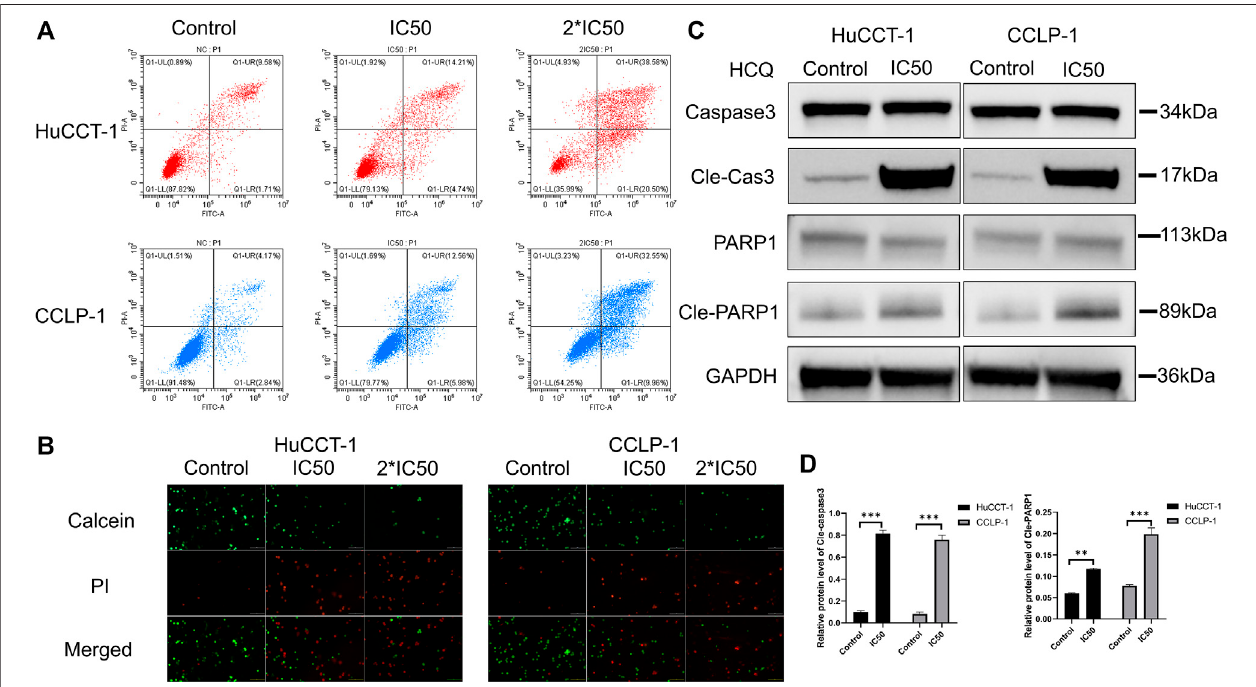
FIGURE 3 | HCQ induces apoptosis in cholangiocarcinoma cells. (A – B) HuCCT-1 and CCLP-1 cells were treated with HCQ (IC50 and 2*IC50 concentrations) for 24 h, and apoptotic cells were analyzed by fl ow cytometry and Live/Dead cell assay. (C) Cells were treated with the IC50 concentration of HCQ for 24 h, and the apoptosis-related proteins were analyzed by western blotting. (D) The histograms indicate the relative protein level of cleaved caspase 3 and cleaved PARP1. All values are expressed as mean ± SD. ** p < 0.01, *** p < 0.001, signi fi cant difference compared with the control